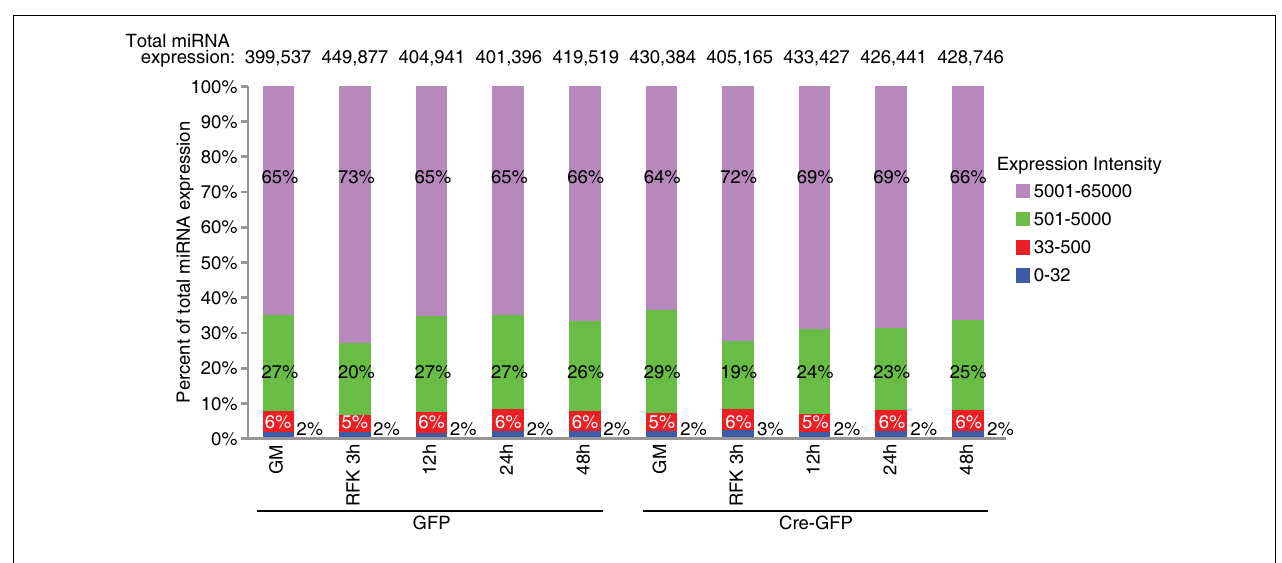
5000 count for more than 20–30% of the total miRNA expression and about 2% with an intensity score above 5000 comprised 60–70% of the total expression.